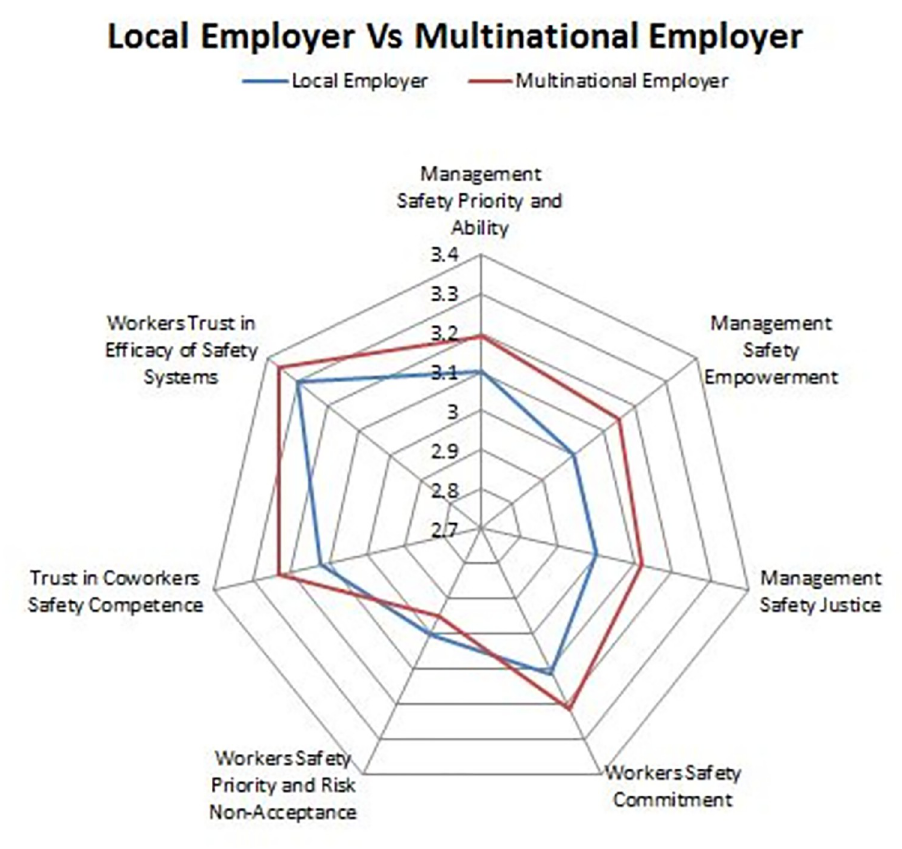
Fig 1. Overall safety climate scores were obtained by both